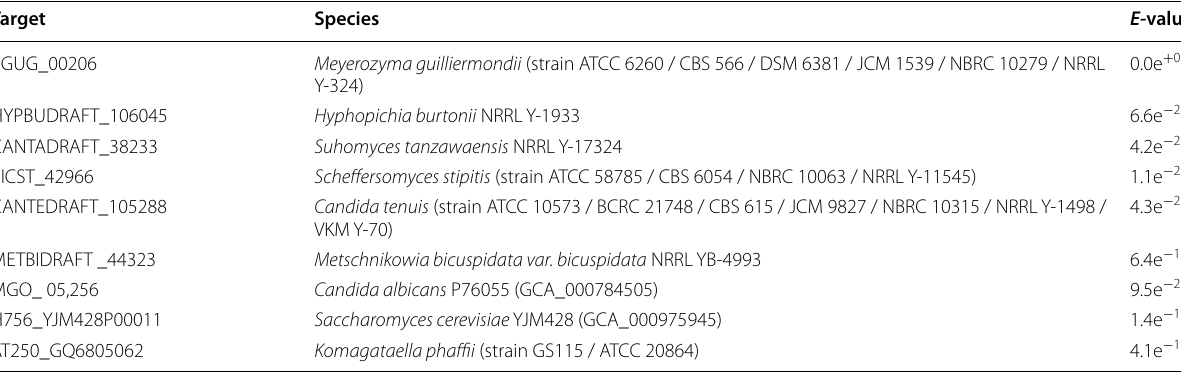
Table 3 HMM homologs hits on M. guilliermondii strain SO phospholipase C Target